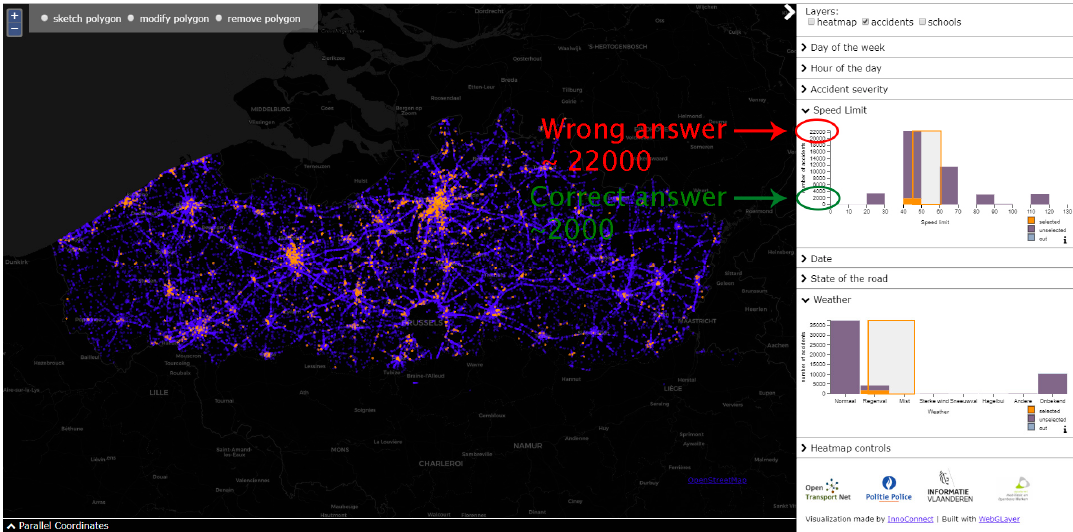
Figure 13. Problematic Task 2 in Flanders map.